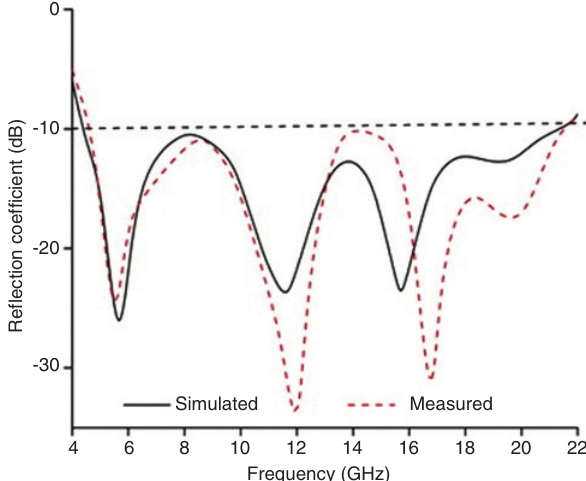
Figure 11: Measured and simulated reflection coefficient of the ground plane decrease in size, the antenna characteris- tics are affected by the SMA connector. That is why a little deviation is observed in measured and simulated value of the reflection coefficient. The impedance matching of the proposed antenna is observed using the Smith chart, presented in Figure 12. From the measured Smith chart, it is shown that the antenna achieved better impedance matching. The corresponding electronic dimension of the proposed antenna is 0.37 λ × 0.37 λ × 0.01 λ ; here, λ refers to the lower-end frequency that meets the -10-dB reflection coefficient. The antenna shows fractional bandwidth of 131.81% at the lower frequency. Moreover, the compact- ness and wideband characteristics of the antenna have been determined using an index term bandwidth dimen- sion ratio (BDR). This index term indicates how much operating bandwidth (in percentage) can be provided per